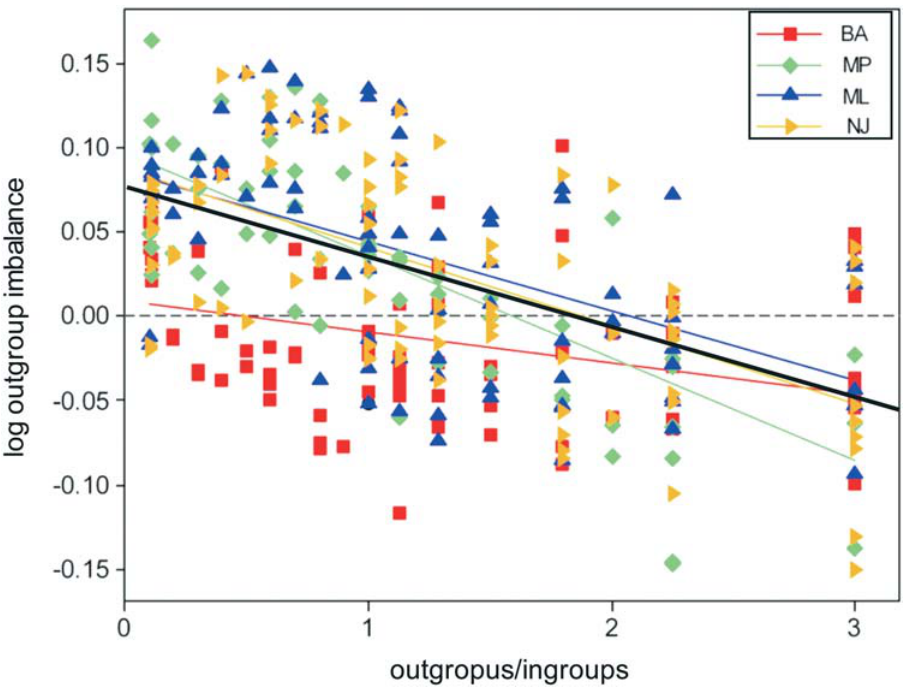
Figure 4. Values of log outgroup imbalance plotted against the relative proportion of outgroups in the dataset of trees obtained applying four tree-building methods to 100 combinations of a set of outgroup and ingroup taxa. Linear regressions are shown for each tree-building method, and for the whole set of 400 trees (thick black line). BA=Bayesian, ML=maximum likelihood, MP=maximum parsimony, NJ=BIONJ distance